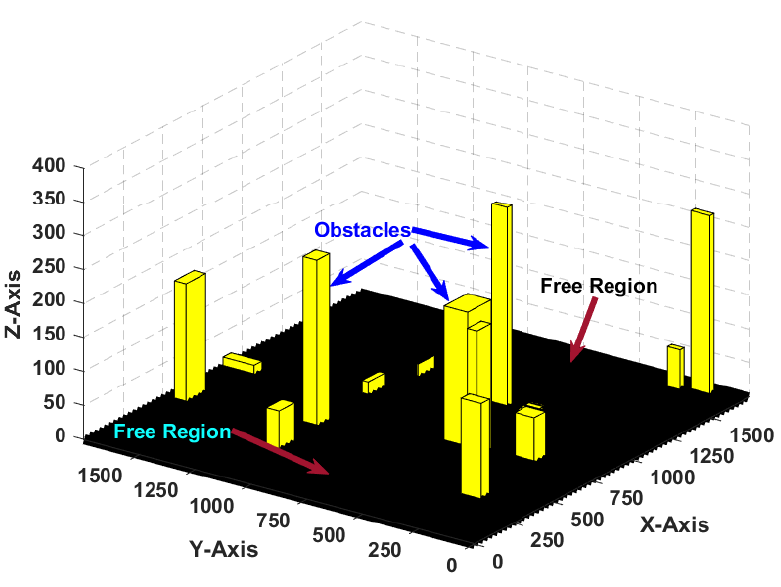
Figure 2. Example of obstacle-free ( ξ free ) and obstacles ( ξ obstacles ) regions in environment map W